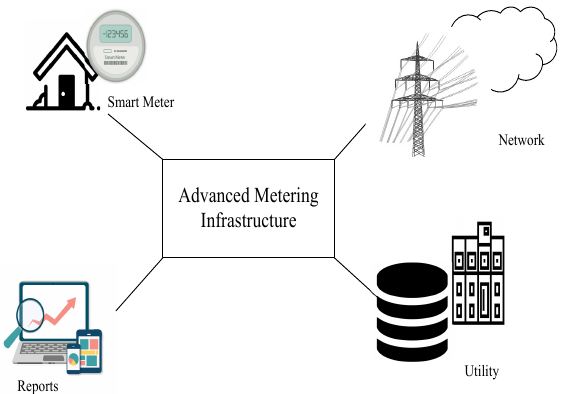
Figure 3. Advanced metering infrastructure.